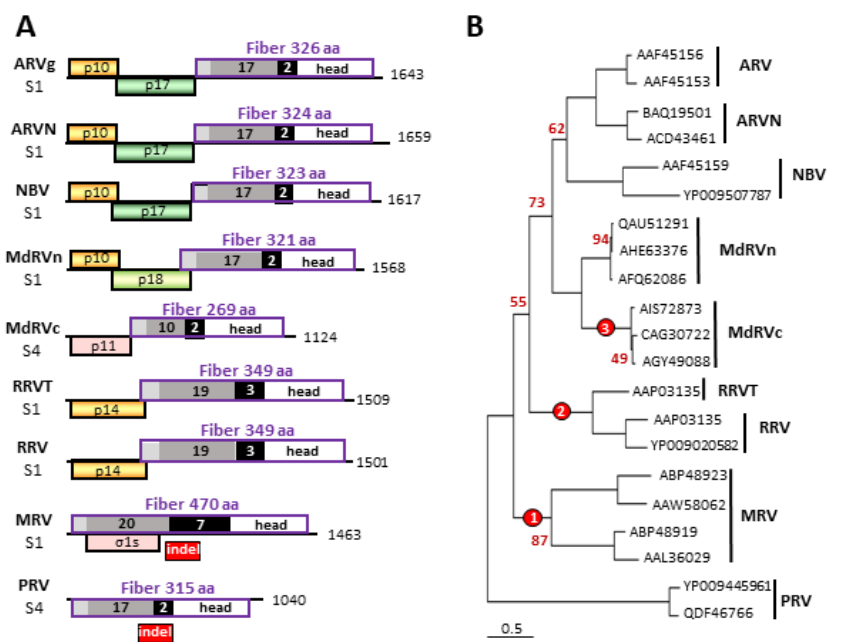
Figure 2. Phylogenetic analysis of orthoreovirus fiber proteins and comparisons of their polycistronic genome segments. ( A ) Diagrams of the fiber encoding S1 and S4 genome segments from the indicated orthoreovirus species, drawn to approximate scale. Numbers refer to mRNA length. Open reading frames are depicted by rectangles, labeled to indicate the protein product and color-coded to depict functional or evolutionary protein relationships: yellow—FAST protein; green—potential cell cycle inhibitory protein; pink—heterologous non-fusogenic protein of no defined function; purple outline—fiber protein. Shading within the fiber ORFs depicts the four main structural features of the fiber protein: N-terminal anchor region (light grey), heptad repeat region (dark grey), β -spiral repeats (black), and globular head (white). Numbers embedded in the shaded areas indicate the number of predicted or demonstrated heptad or β -spiral repeats. The location of the polymorphic indel region is indicated below the Mammalian orthoreovirus (MRV) and Piscine orthoreovirus (PRV) fiber protein ORFs. ( B ) Maximum likelihood unrooted phylogram of the fiber proteins of the seven indicated orthoreovirus species or proposed species and the MdRVn and classical Muscovy duck reovirus (MdRVc) subgroups of waterfowl ARV isolates. The tree with the highest log likelihood is shown and included 21 amino acid sequences. The virus isolates used for the analysis are indicated by their accession numbers. Bootstrap values (500 replicates) indicating the percentage of trees in which the associated taxa clustered together in < 95% of the replicate trees are shown next to the branches. Branch lengths are to scale and measured in the number of substitutions per site. The locations of three indel events that generated the extant fiber proteins are indicated (red